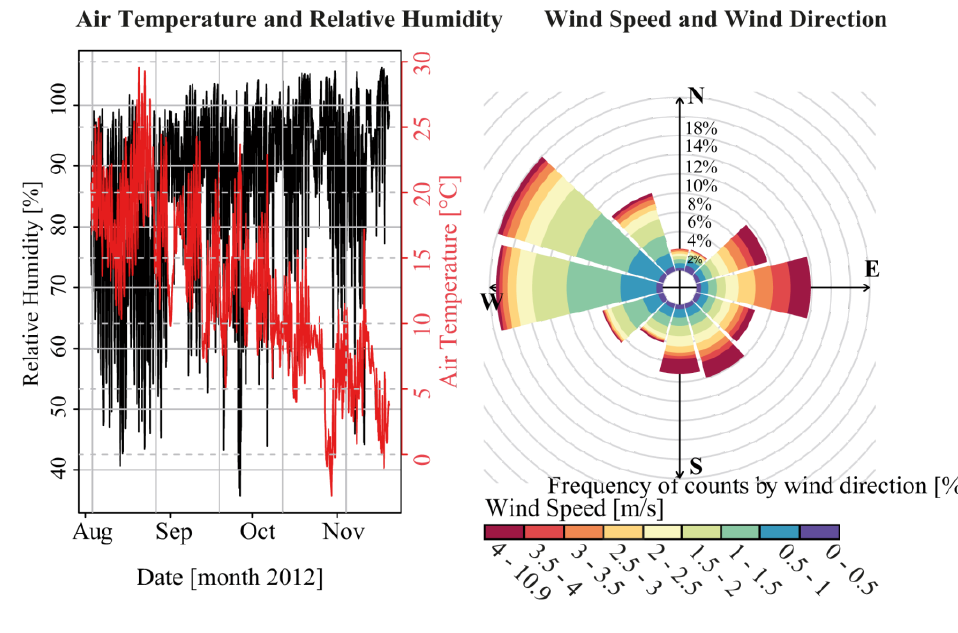
Figure 4. Measured air temperature and relative humidity ( left ) as well as wind speed in relation to wind direction ( right